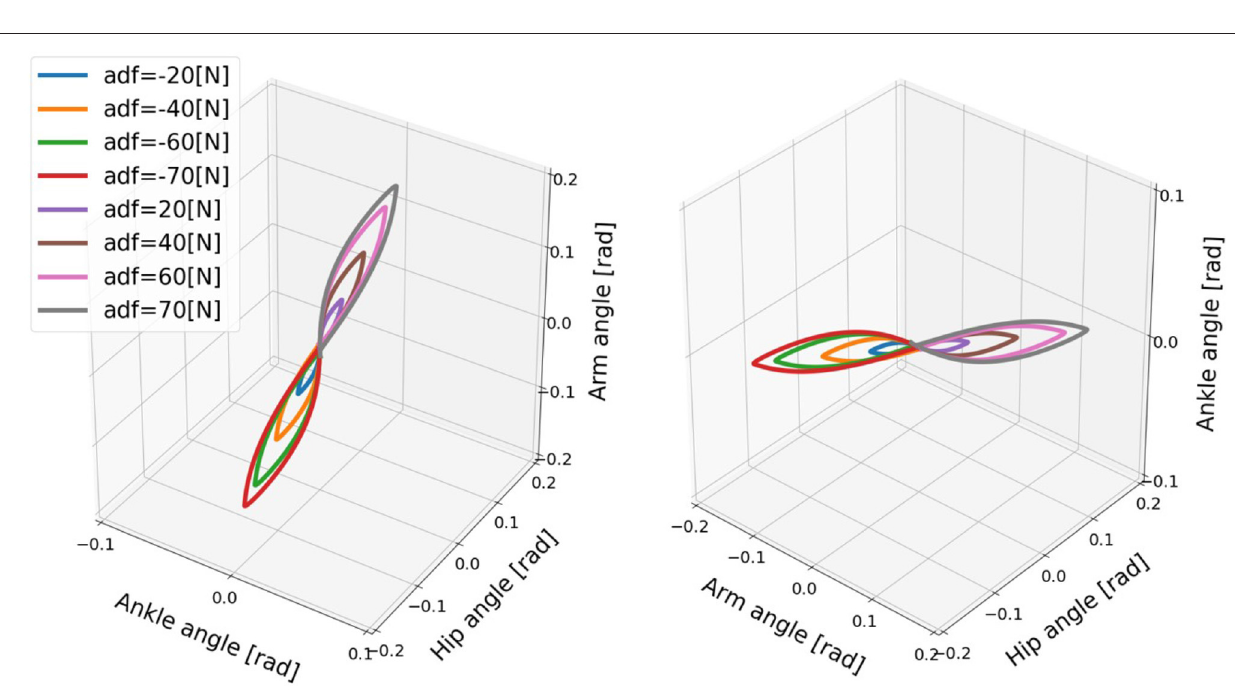
RMS deviation is seven times those in cases (2) and (3),